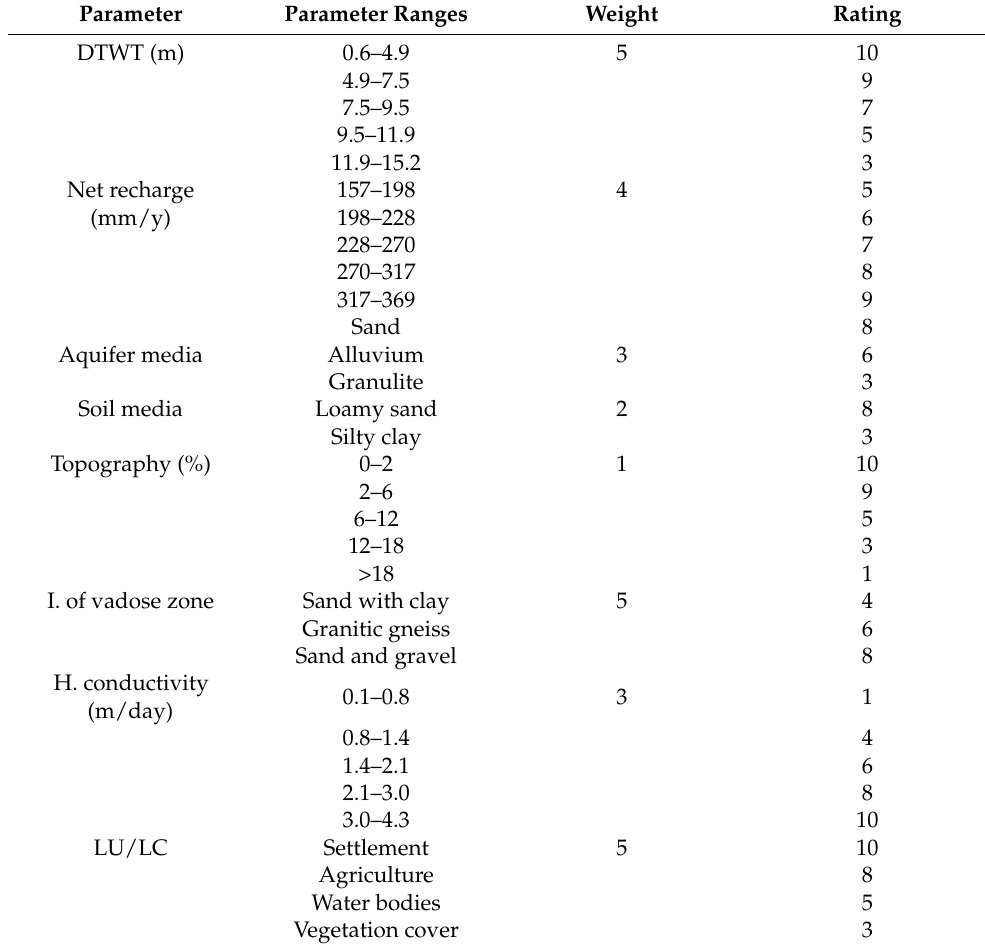
Table 1. Weight and rating of the DRASTIC-LU/LC parameters.